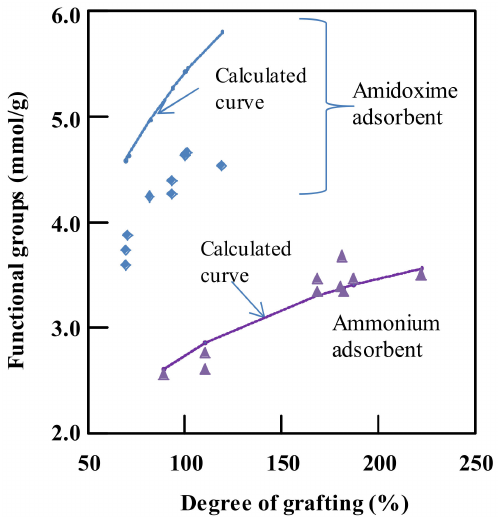
Figure 3. Functional groups in the amidoxime and ammonium adsorbents as a function of the degree of grafting. The amidoxime adsorbent is obtained by immersing the AN/MAA-grafted fabric in a hydroxylamine solution at 80 ◦ C for more than 15 min; and the ammonium adsorbent is obtained by immersing the CMS-grafted fabric in a trimethylamine solution at 80 ◦ C for more than 30